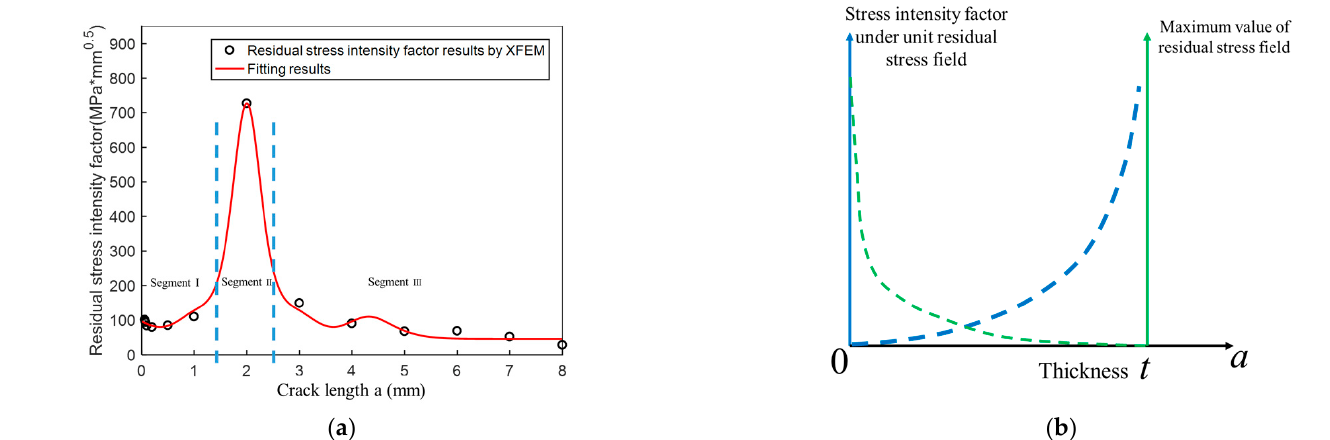
Figure 15. Comparison of calculation results of stress intensity factor with M k and XFEM method. The effect of residual stress on the crack propagation can be best seen by observing the stress intensity factor. The XFEM calculation results of the model presented in Figure 9 are shown in Figure 16a, which also describes the parameter K e (Equation (6)). Based on the change of the stress intensity factor, the curve of residual stress intensity factor can be divided into three segments. Materials 2020 , 13 , x FOR PEER REVIEW 14 of 20